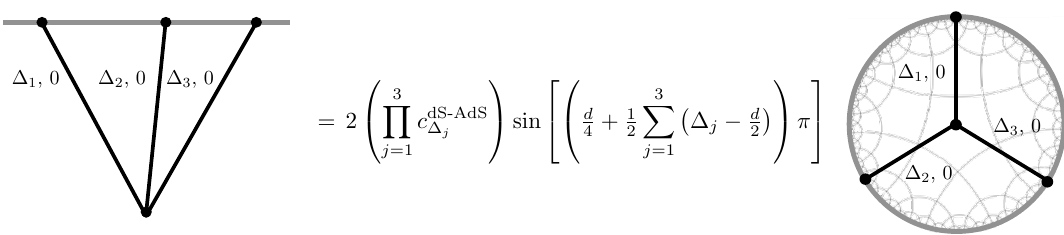
Figure 12. Upon summing the contributions from the ± branches of the in-in contour to obtain the full dS contact diagram, the constant phases from the individual ± branch contributions — which have opposite sign — combine to give a constant sinusoidal factor multiplying the corresponding contact diagram in